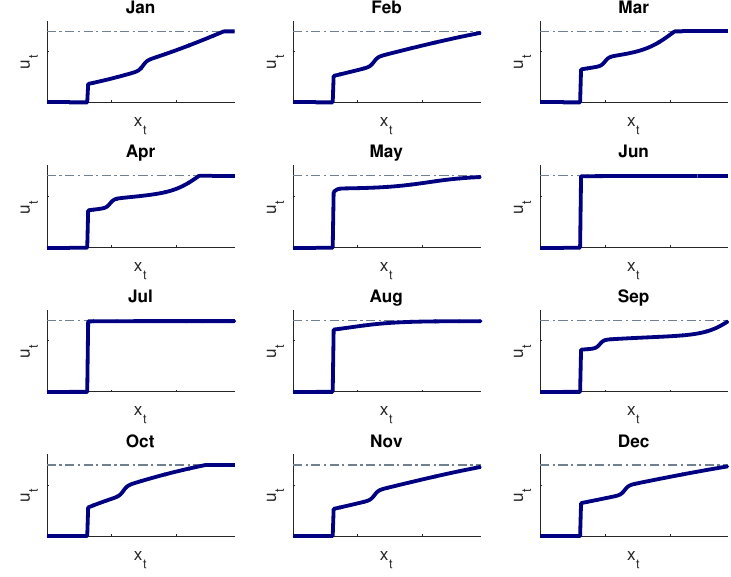
Figure 9. Control laws for Lake Nasser with decentralized and incomplete information: the release is expressed as function of the